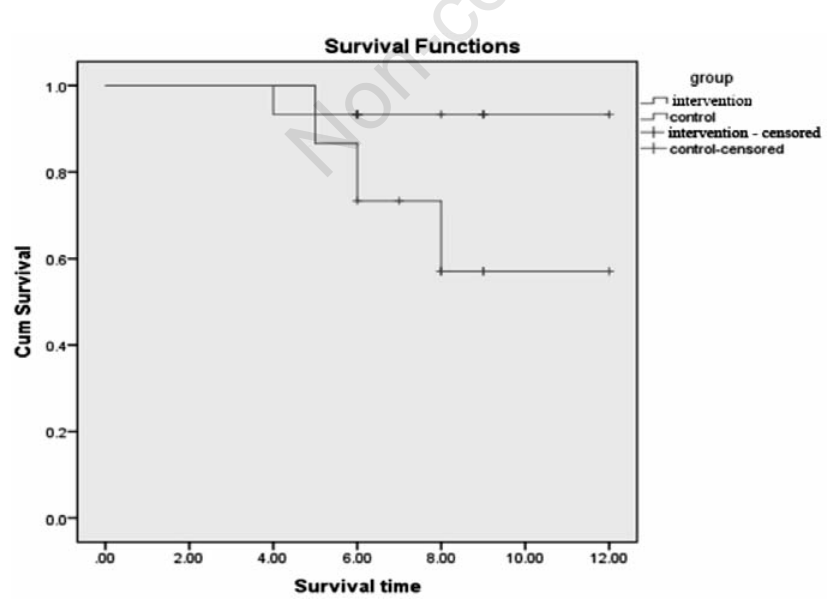
Figure 1. Survival curves of patients in the intervention and control